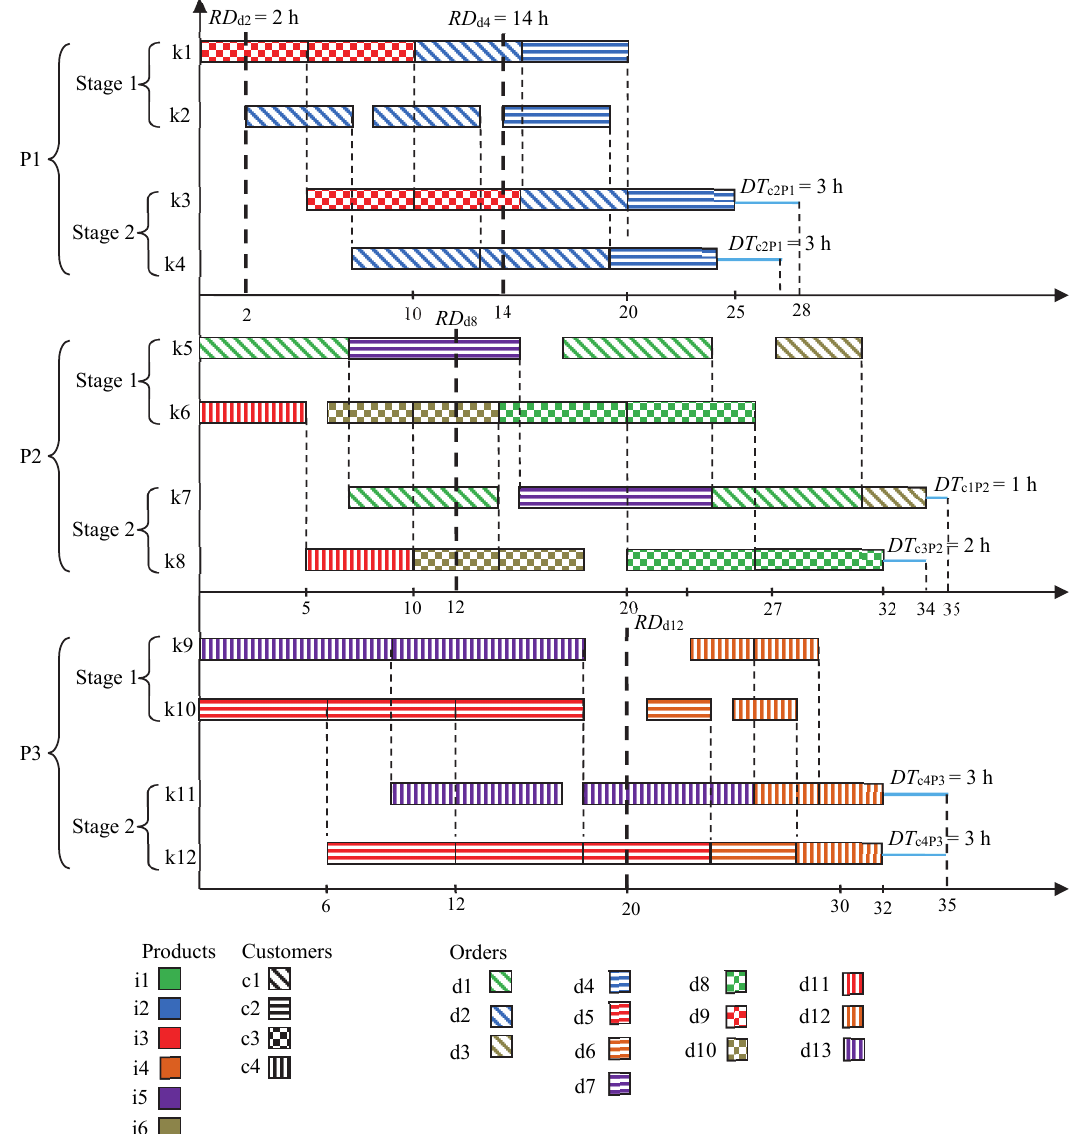
Fig. 8. Gantt chart for competition policy of Example